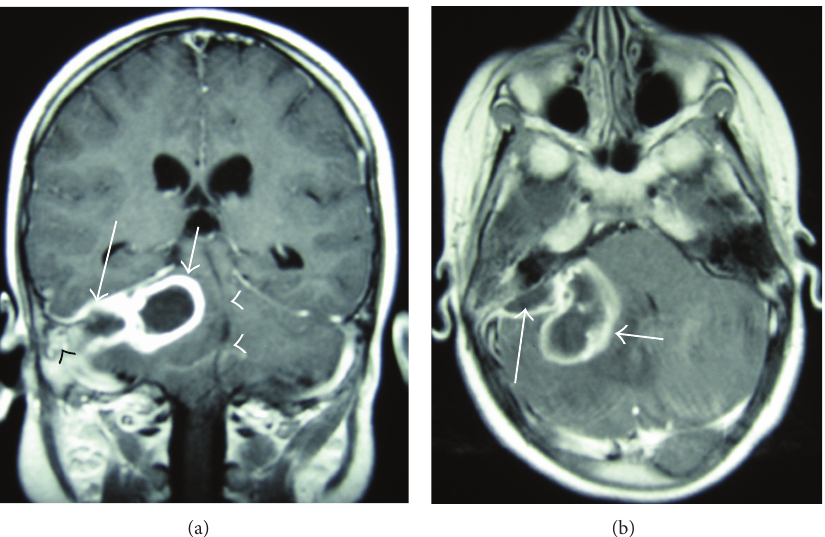
Figure 1: Coronal (a) and axial (b) MRI sections with contrast on admission, showing a large cerebellar abscess on the right hemisphere (short arrows) coexisting with an epidural abscess of the posterior fossa (long arrows) and inflammatory tissue within the mastoid cavity ((a), black arrowhead). The abscesses exert mass effect against the middle-line structures, causing their displacement to the left ((a), white